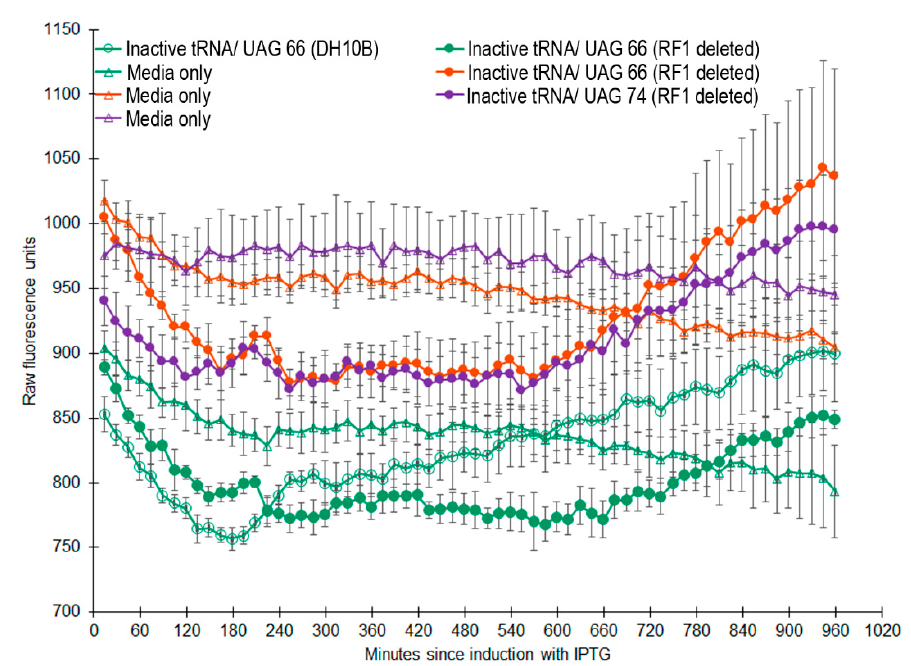
Figure A1. Raw fluorescence versus time profiles of single site UAG GFP reporter variants in the absence of an M. jannaschii tRNA capable of suppressing amber codons. Error bars represent the standard deviation across 6 biological replicates of each cell system (12 wells for media only). Data from experiments using two different media preparations are shown and reveal the contribution of media fluorescence to total fluorescence observed in non-reassigning systems.